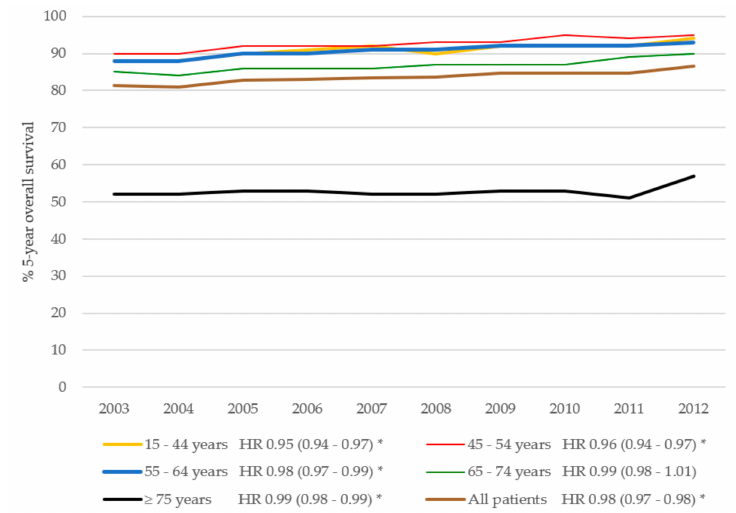
Figure 4. Five-year overall survival in BC patients over time per age group. HR indicates hazard ratio per year, adjusted for grade, stage, and treatment. * Significant ( p < 0.05).